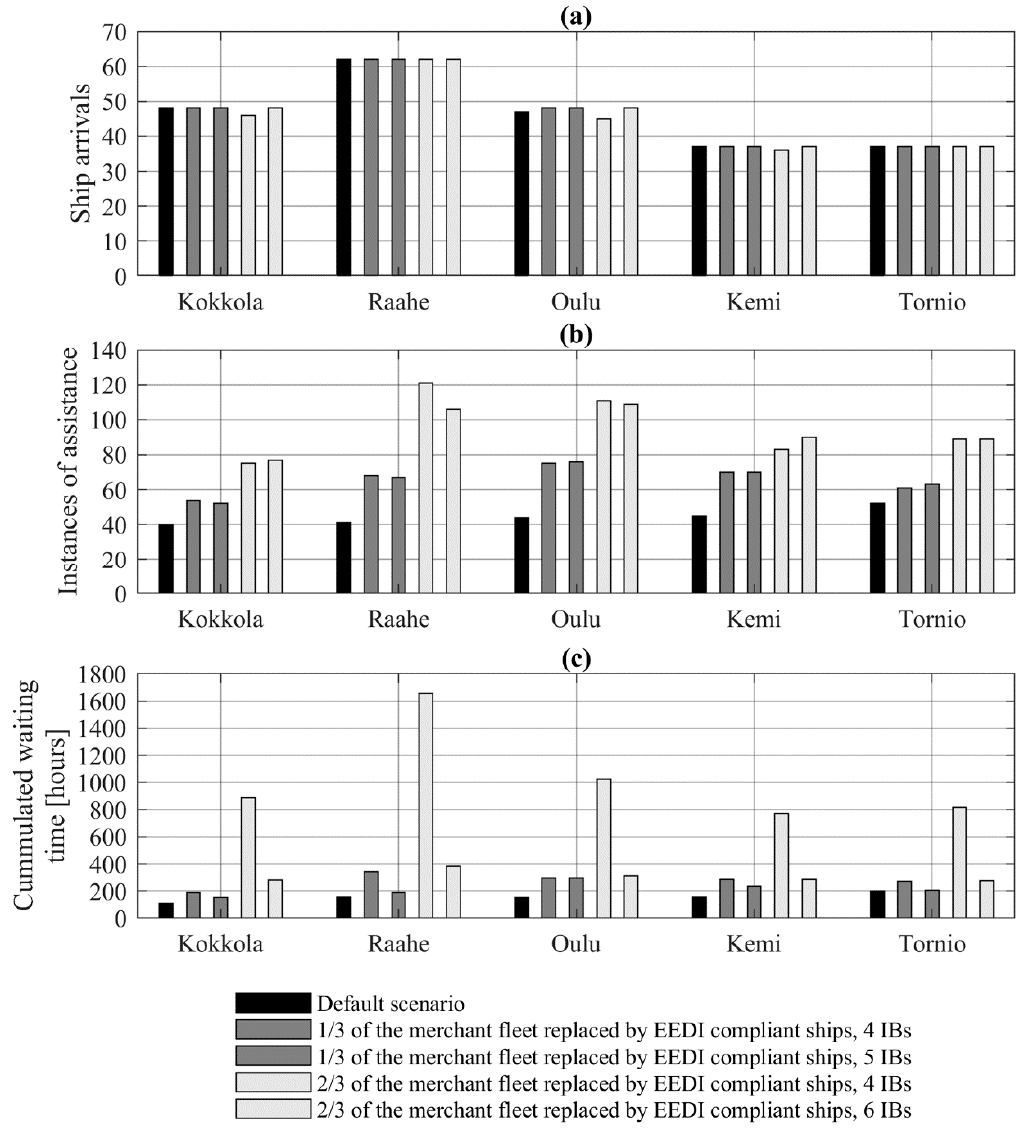
Figure 11. Influence of various EEDI scenarios on the operating performance of the Finnish–Swedish Winter Navigation System (FSWNS). ( a ) ship arrivals; ( b ) instances of assistance; ( c ) commulated waiting times, The results were obtained by repeating the simulation for the various fleet configurations considered, keeping all other parameter values constant. The cumulated port-specific waiting times reflect both the number of instances of assistance and the mean waiting time per instance.